Question: In one sentence, what is this figure communicating?
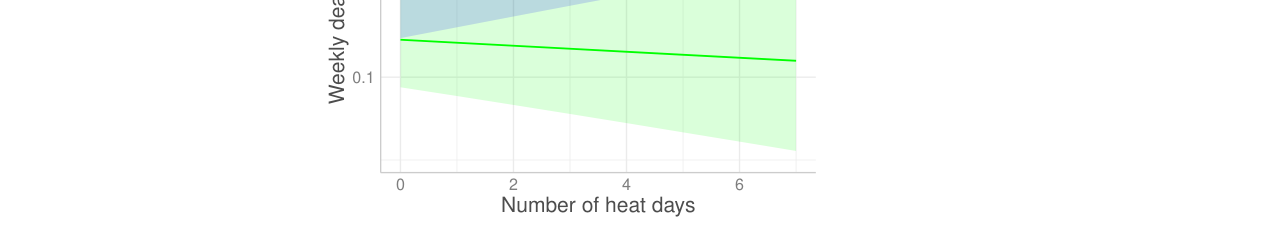
Answer: The marginal effects of additional heat days on mortality in Austrian districts, conditioned on the share of the population above 65. The marginal impact of an additional heat day on mortality is significantly larger in districts with an older population. Estimates are derived from Model 2 in Table 2, and we report 90% confidence intervals derived from robust standard errors.